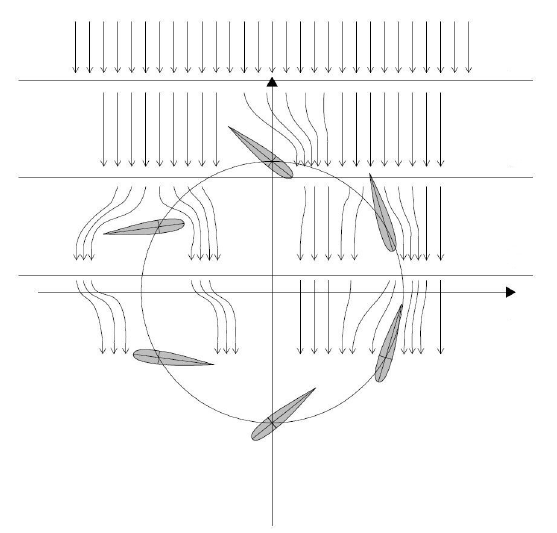
Figure 6. Shielding phenomena [21].